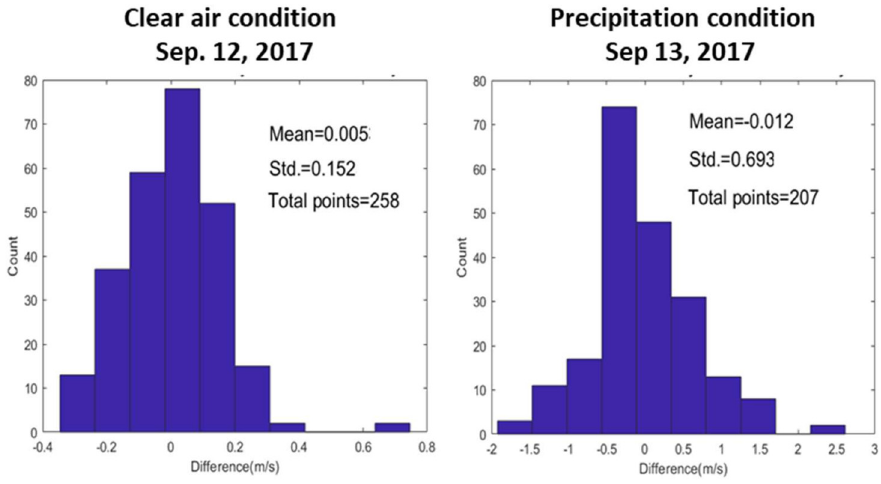
Figure 16. Histograms of vertical wind differences between VAD method and vertical beam obser- vations in clear air conditions ( left ) and precipitation environment ( right ) for the data shown in Figure